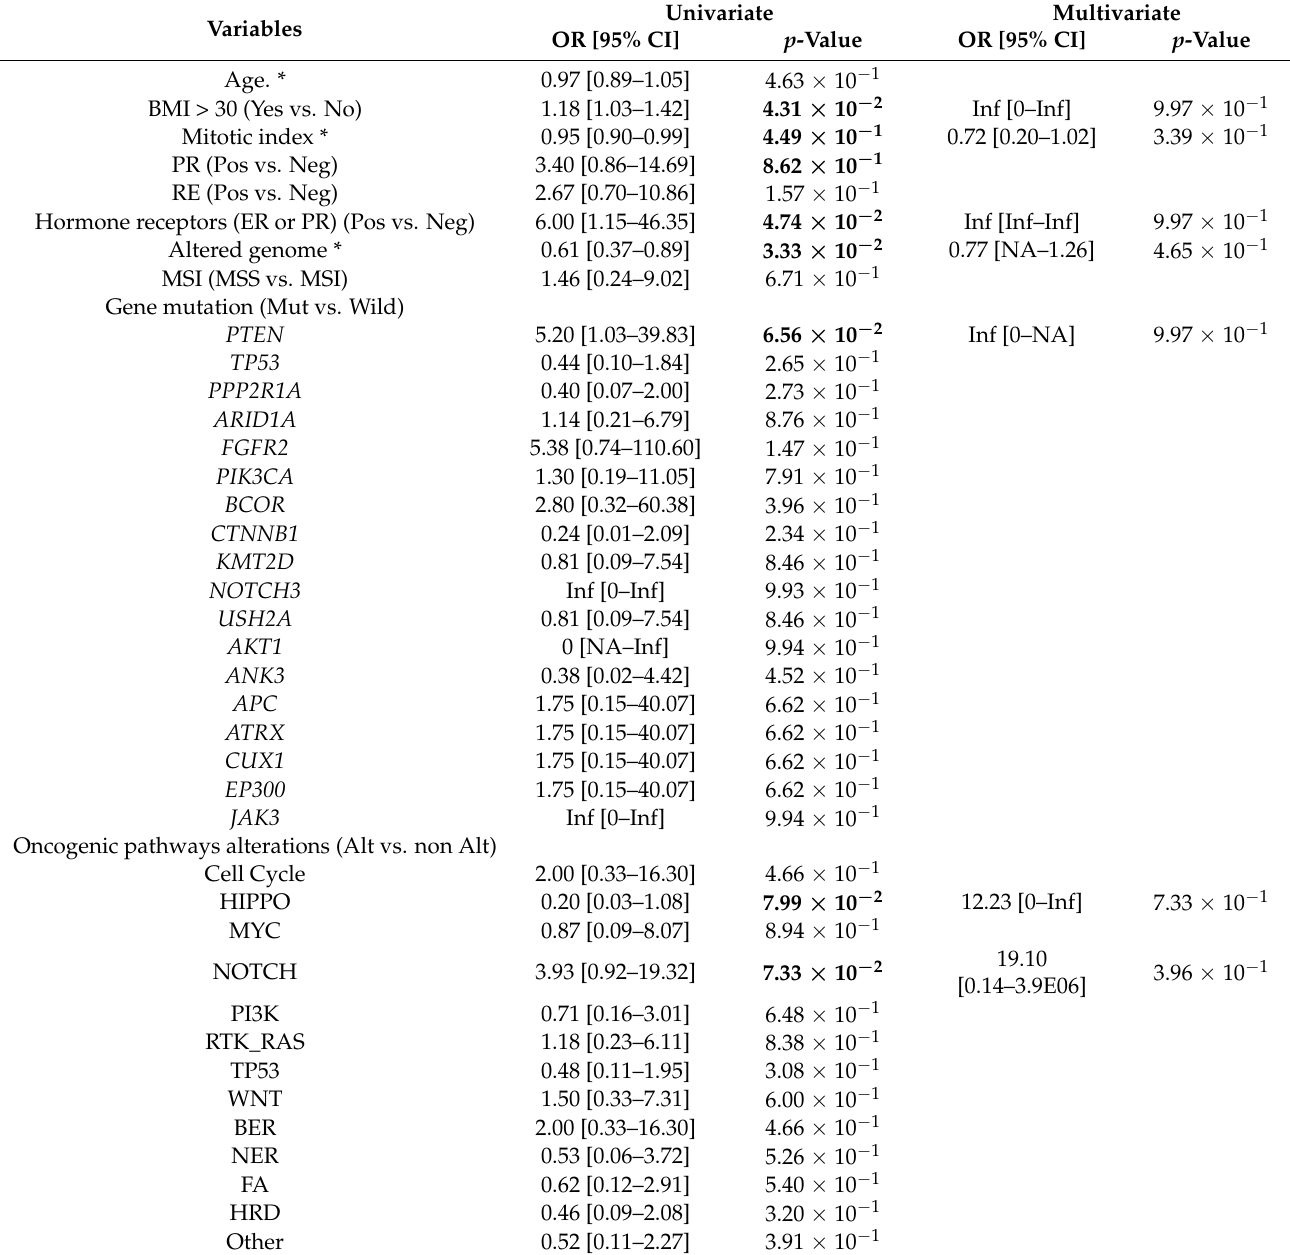
Table 2. Results of univariate and multivariate analyses for